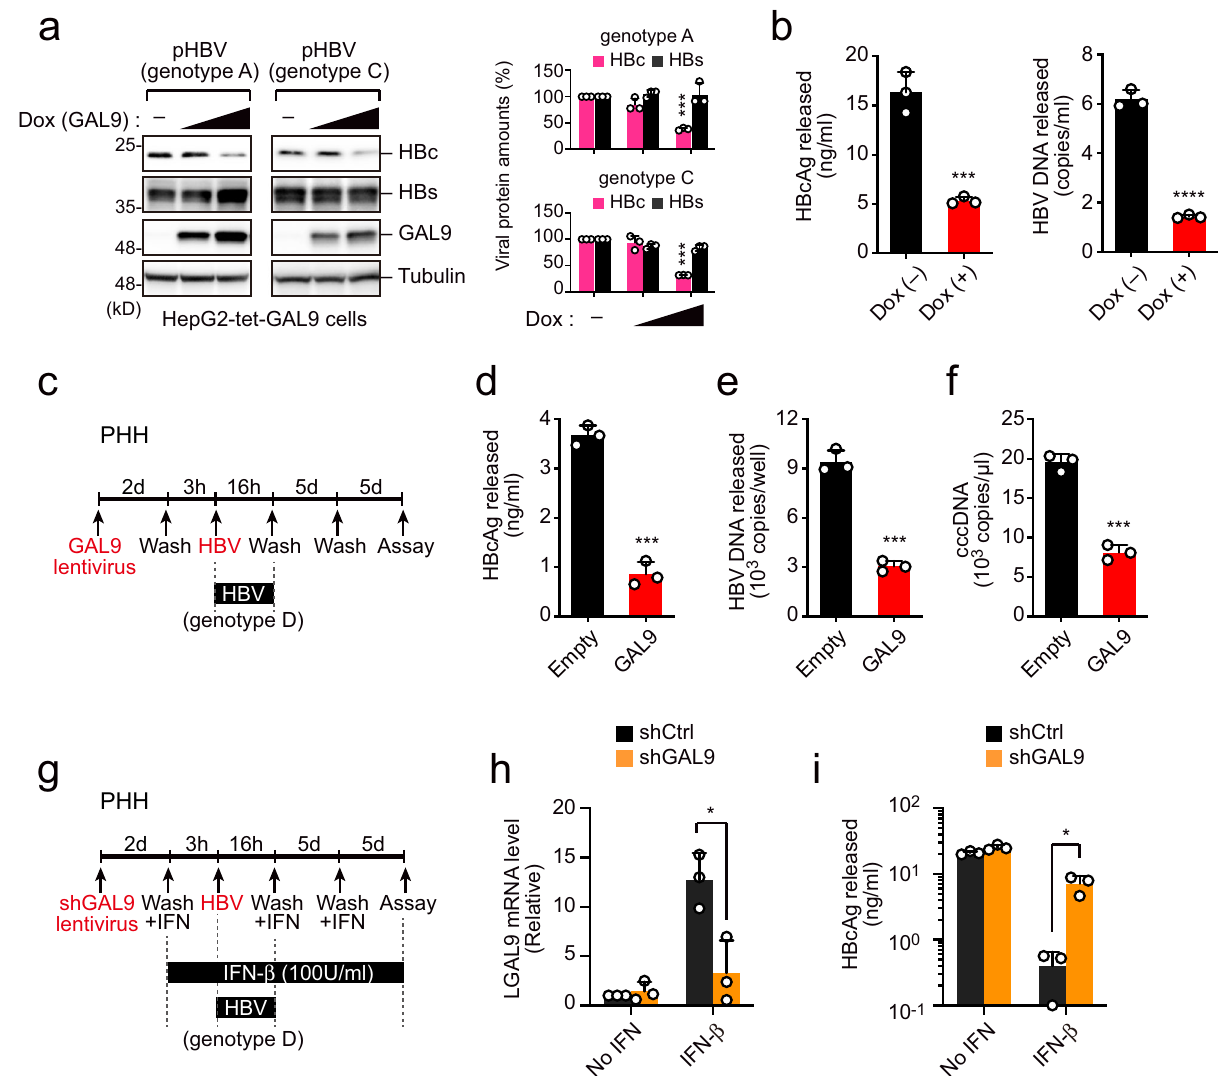
Fig. 6 GAL9 acts as an IFN-inducible antiviral factor. a Induced GAL9 degrades intracellular HBc. HepG2-tet-GAL9 cells were transfected with pHBV genotype A or C, and then were treated with doxycycline (0.5 or 1 µ g/mL) to induce GAL9. Cells were subjected to immunoblotting analysis to detect the indicated proteins. Bar charts indicate the ratio of HBc or HBs over Vinculin, as determined by densitometry, are presented as a mean ± SD ( n = 3 experiments). **** P < 0.0001, two-tailed unpaired t -test. b Induced GAL9 inhibits HBV particle release. HepG2-tet-GAL9 cells were transfected with pHBV (genotype C). Four hours after transfection, the cells were washed three times and treated with doxycycline. Three days after transfection, supernatants were harvested, followed by the detection of HBcAg and viral DNA. Bar charts are presented as a mean ± SD ( n = 3 experiments). *** P = 0.0008, **** P < 0.0001, two-tailed unpaired t -test. c – f GAL9 inhibits HBV replication. The experimental design is presented in c . Primary human hepatocytes (PHHs) were transduced with lentiviral vectors carrying a GFP empty vector or GFP-GAL9 2 days before HBV infection. Eleven days after infection, supernatants were subjected to HBcAg ELISA ( d ) and qPCR ( e ) to detect released infectious HBV. The cells were subjected to qPCR to detect the cccDNA ( f ). Bar charts are presented as a mean ± SD ( n = 3 experiments). *** P = 0.0001 ( d , e ), *** P = 0.0002 ( f ), two-tailed unpaired t -test. g – i GAL9 depletion attenuates IFN antiviral activity. The experimental design is shown in ( g ). PHHs transduced with control (Ctrl) or GAL9-targeting shRNA were infected with HBV in the presence or absence of IFN- β (100 U/mL). Eleven days after infection, the cells were subjected to qPCR to detect GAL9 expression ( h ). The supernatants were subjected to HBcAg ELISA to detect the released HBV ( i ). Bar charts are presented as a mean ± SD ( n = 3 experiments). * P = 0.0192 ( h ), * P = 0.035 ( i ), two-tailed unpaired t -test. Immunoblots are representative of experiments with similar results ( n ≥ 2). Source data are provided as a Source Data fi